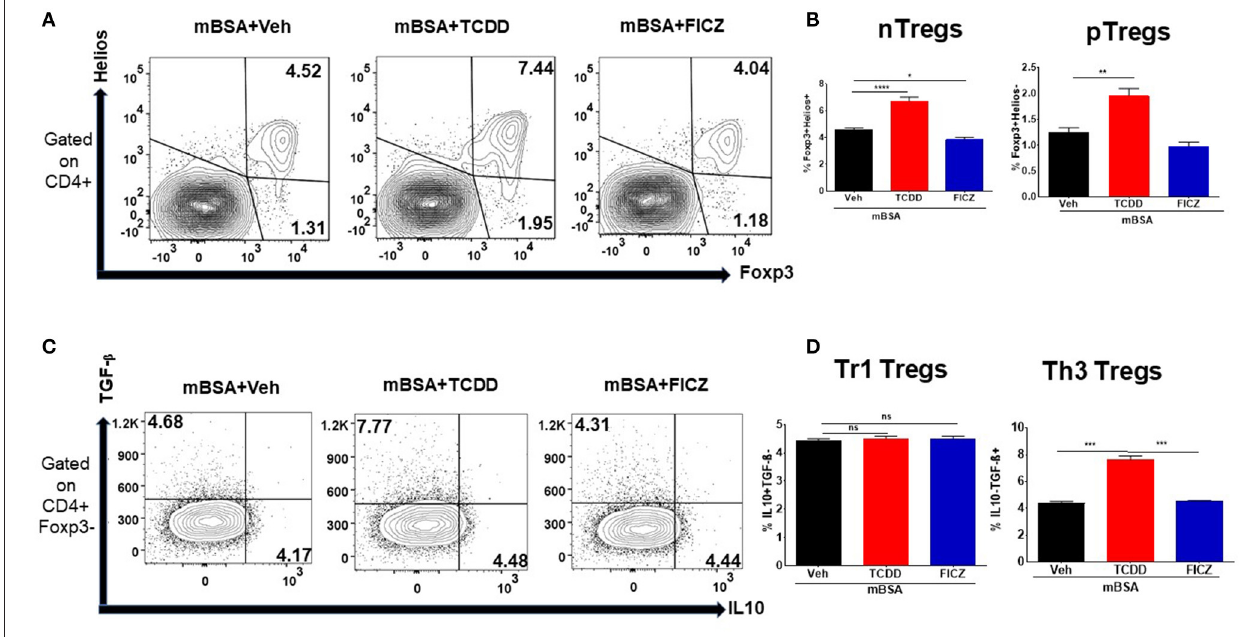
FIGURE 4 | Effect of TCDD on Treg subsets. DTH was induced as described in Figure 1 legend and Treg subsets were studied using DLN cells and flow cytometric analysis for various markers. (A) Representative flow cytometry dot plots gated on CD4 + cells, displaying the percentage of natural Tregs (nTreg) present through co-expression of CD4, FoxP3, and Helios and the percentage of peripheral Tregs (pTreg) that are CD4 + and FoxP3 + , and Helios-. (B) Percentage of (nTregs and pTregs) cells based on groups of 5 mice. (C) Representative flow cytometry dot plots gated on CD4 + Foxp3- cells, displaying the percentage of Tr1 Tregs present through co-expression of CD4 + Foxp3-IL-10 + and the percentage of Th3 Tregs that are CD4 + Foxp3-TGF- β + . (D) Percentage of Tr1 and Th3 Tregs cells based on groups of 5 mice. Vertical bars represent Mean ± SEM and significant difference between groups were indicated by asterisks (* p < 0.05, ** p < 0.01, *** p < 0.001, **** p < 0.0001) based on one-way